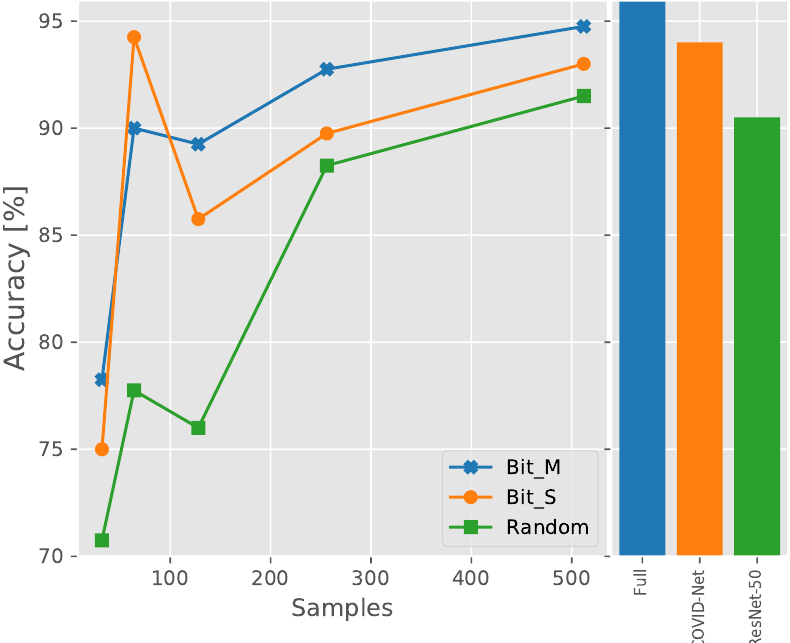
Figure 7. Effect of number of images per category in training set on model